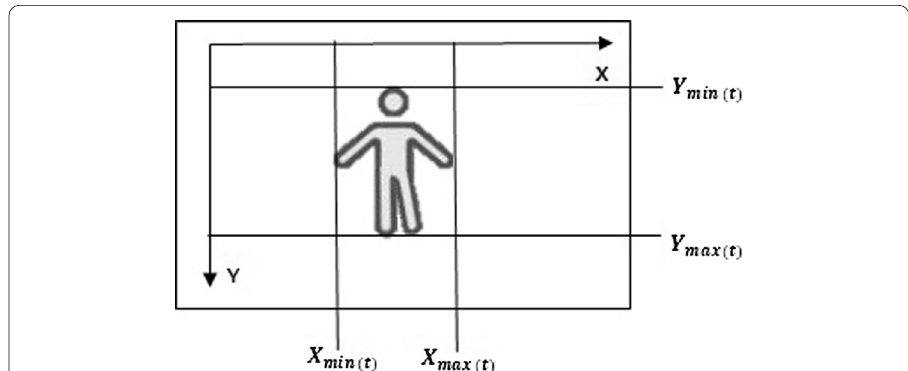
Fig. 5 Define object coordinate points